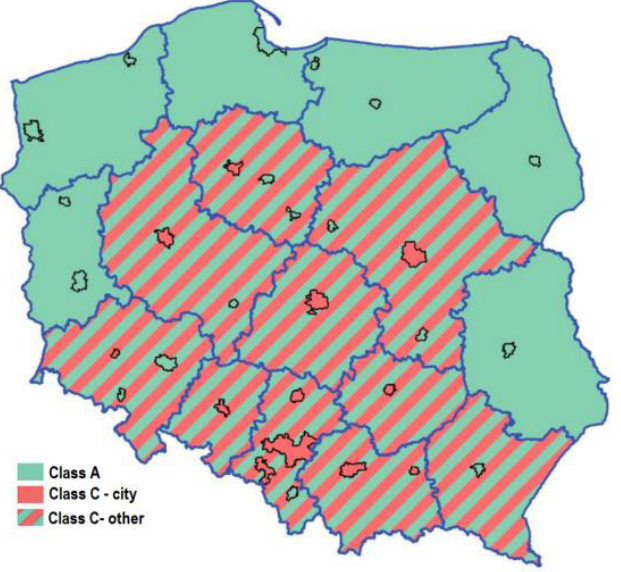
Figure 3. Classification of zones in Poland for PM 10 dust, based on air quality assessment for 2019 [20]. Reprinted with permission from [20]. Copyright 2019, State Environmental Monitoring.